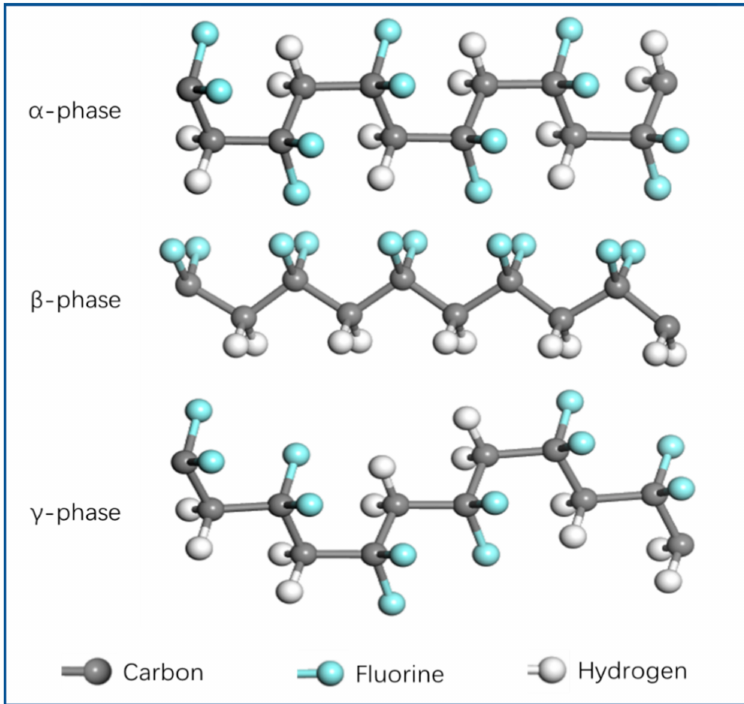
Figure 3. Molecular structure of the α , β , and γ phases of